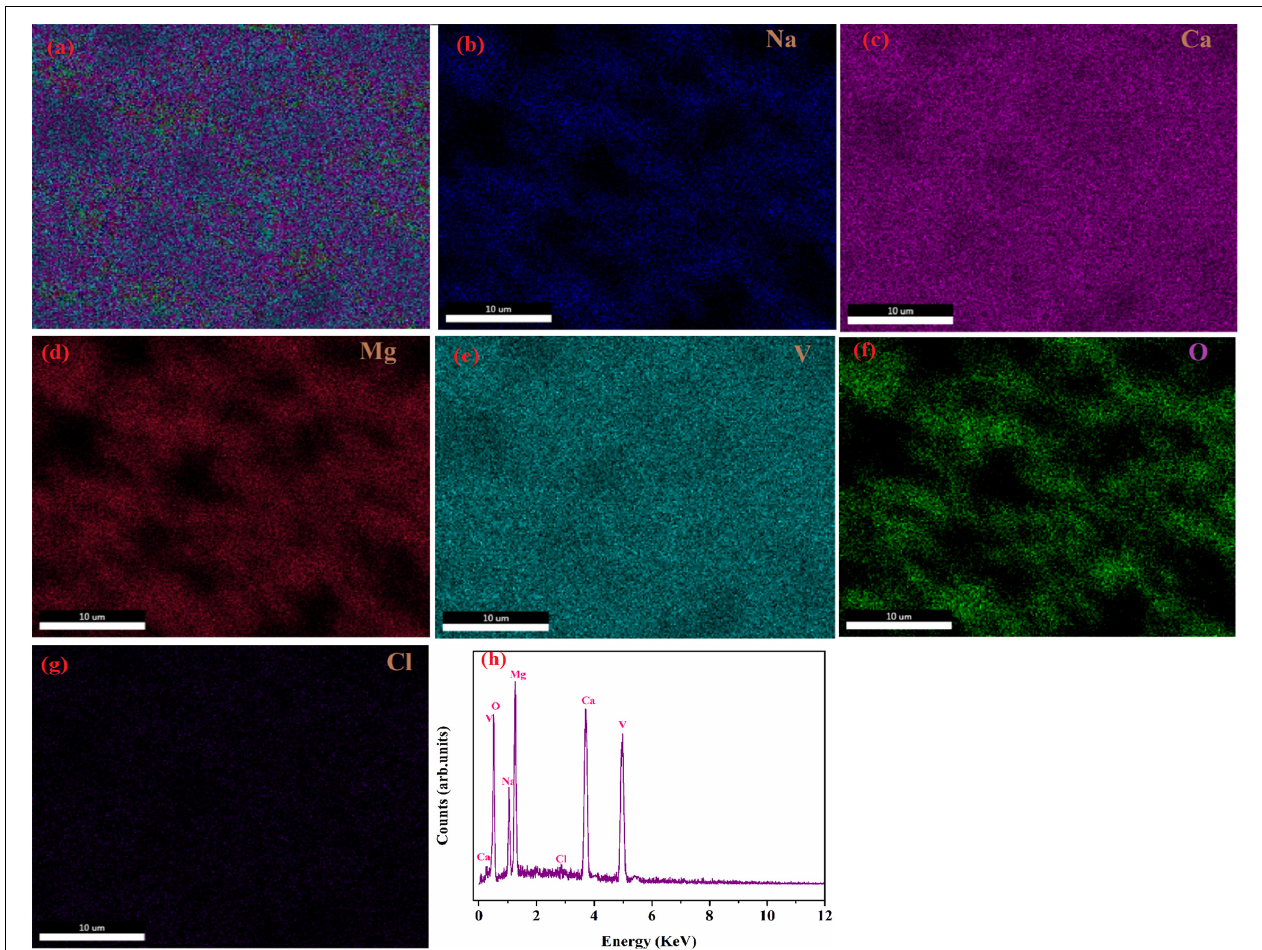
FIGURE 6 | EDS spectra and mapping of 0.5NCMVO-0.5NaCl composite with (a) EDS mapping of 0.5NCMVO-0.5NaCl composite; (b) Na; (c) Ca; (d) Mg; (e) V; (f) O; (g) Cl; and (h) EDS spectra of the 0.5NCMVO-0.5NaCl composites.